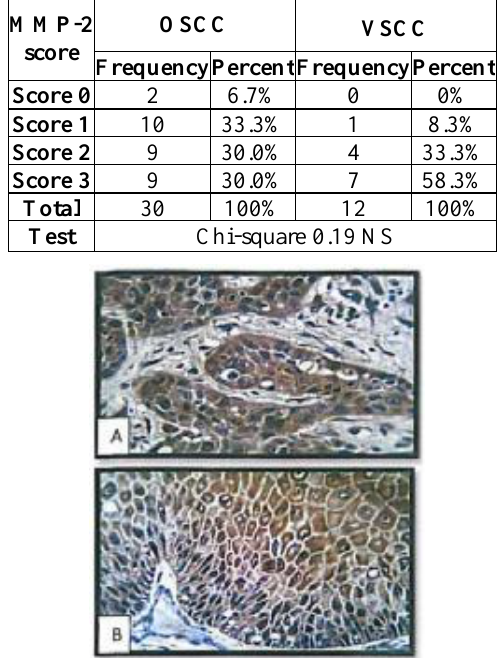
Figure 1: MMP-2 immunoexpression in A.